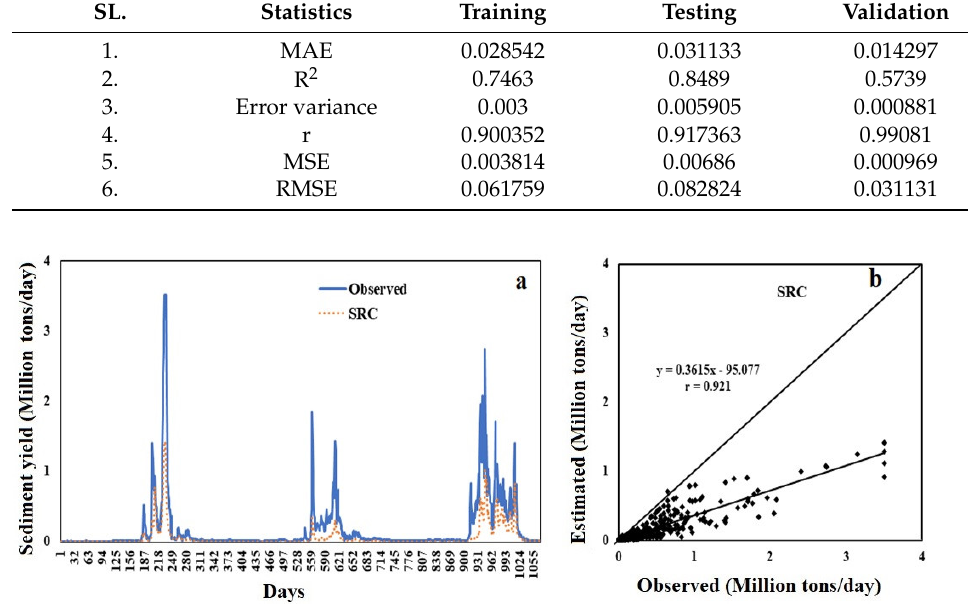
Table 7. Error statistics of SRC model at Polavaram, Godavari River Basin. SL.